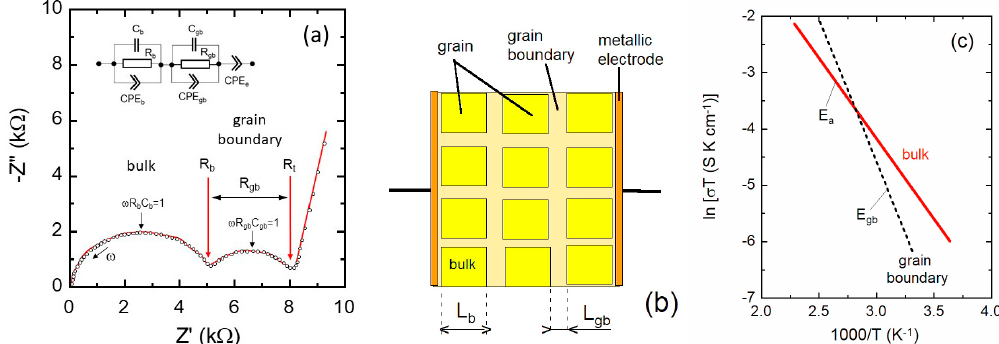
Figure 5. ( a ) Impedance spectrum of a polycrystalline FIC. The equivalent circuit employed to fit the Nyquist plot is shown in inset. ( b ) Scheme of the” brickwork model” of intra- and intergrains in ceramic placed between two metallic electrodes for impedance measurements. ( c ) Typical Arrhenius curves of the conductivities for bulk and grain boundary showing increased intergain activation energy.